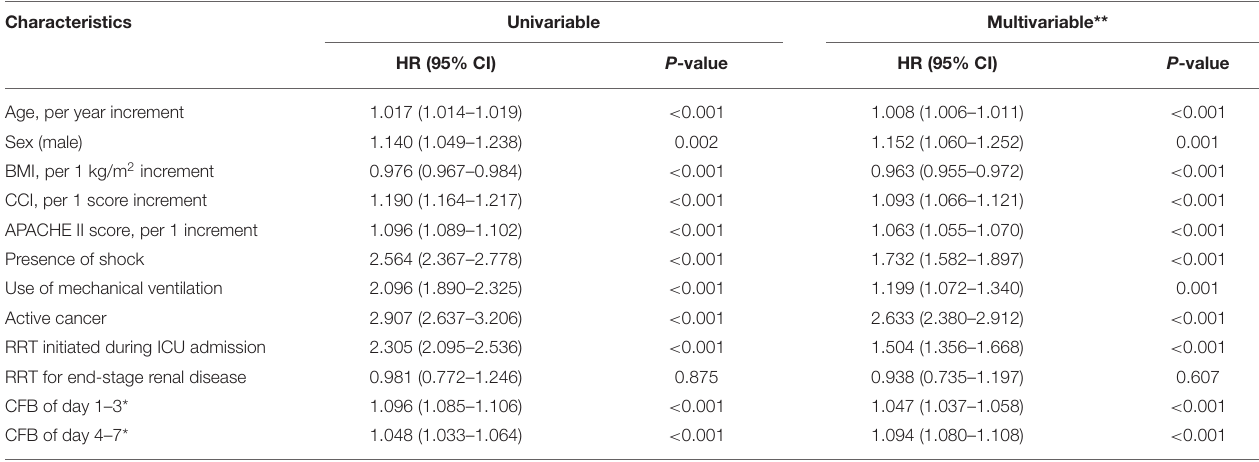
TABLE 3 | Cox proportional hazard regression analysis for long-term